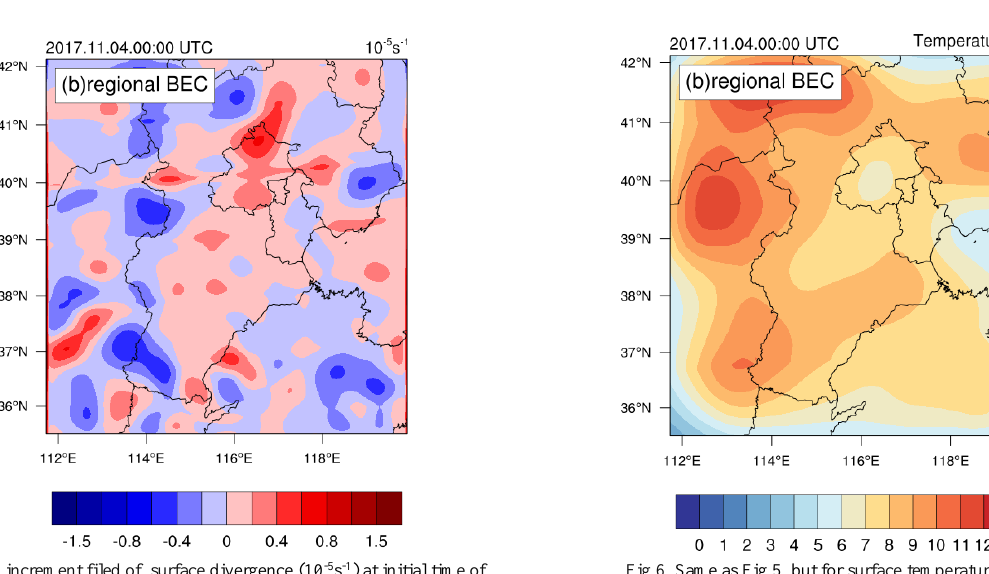
Fig.5.The increment filed of surface divergence (10 -5 s -1 ) at initial time of the innermost domain (a) global BEC (b) region BEC Figure 6 shows the increment field of